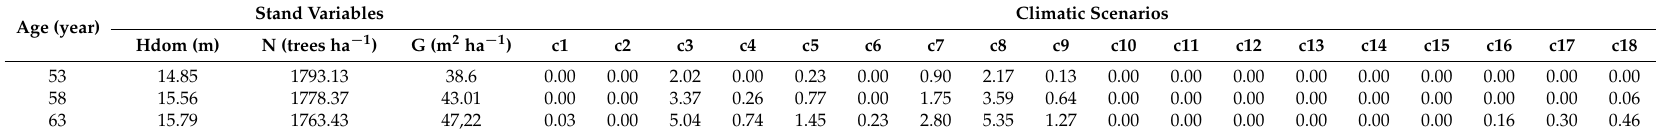
Table 6. Total sporocarp productivity before thinning by climatic